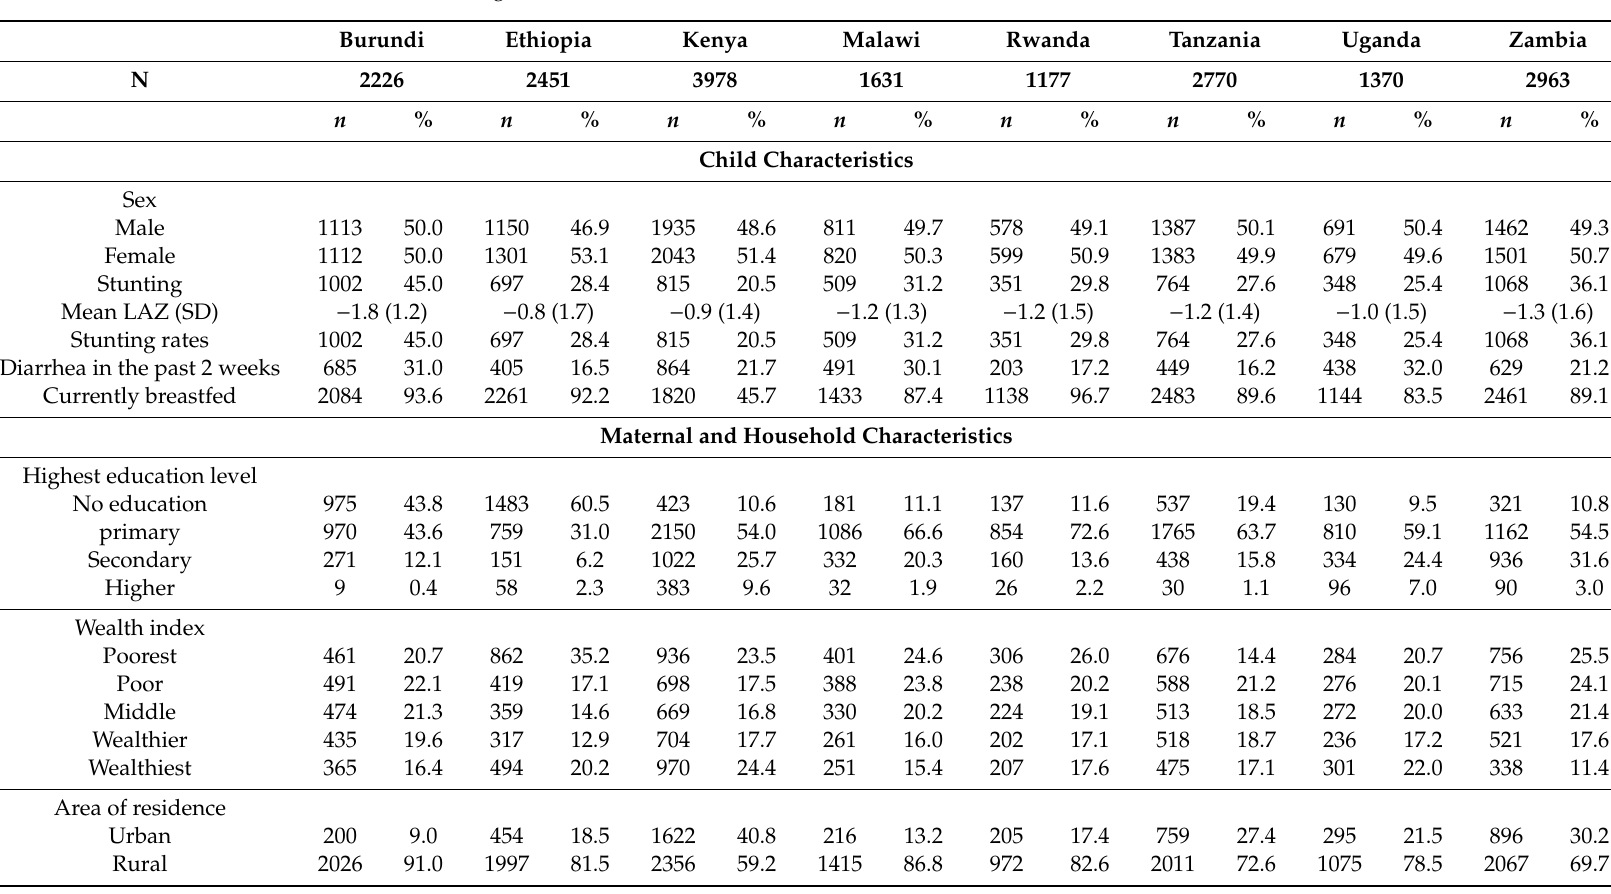
Table 3. Characteristics of the study populations from their most recent Demographic and Health Survey (DHS): Burundi (2016–2017), Ethiopia (2016), Kenya (2015), Malawi (2017), Rwanda (2017), Tanzania (2017), Uganda (2016), and Zambia (2013–2014). Burundi Ethiopia